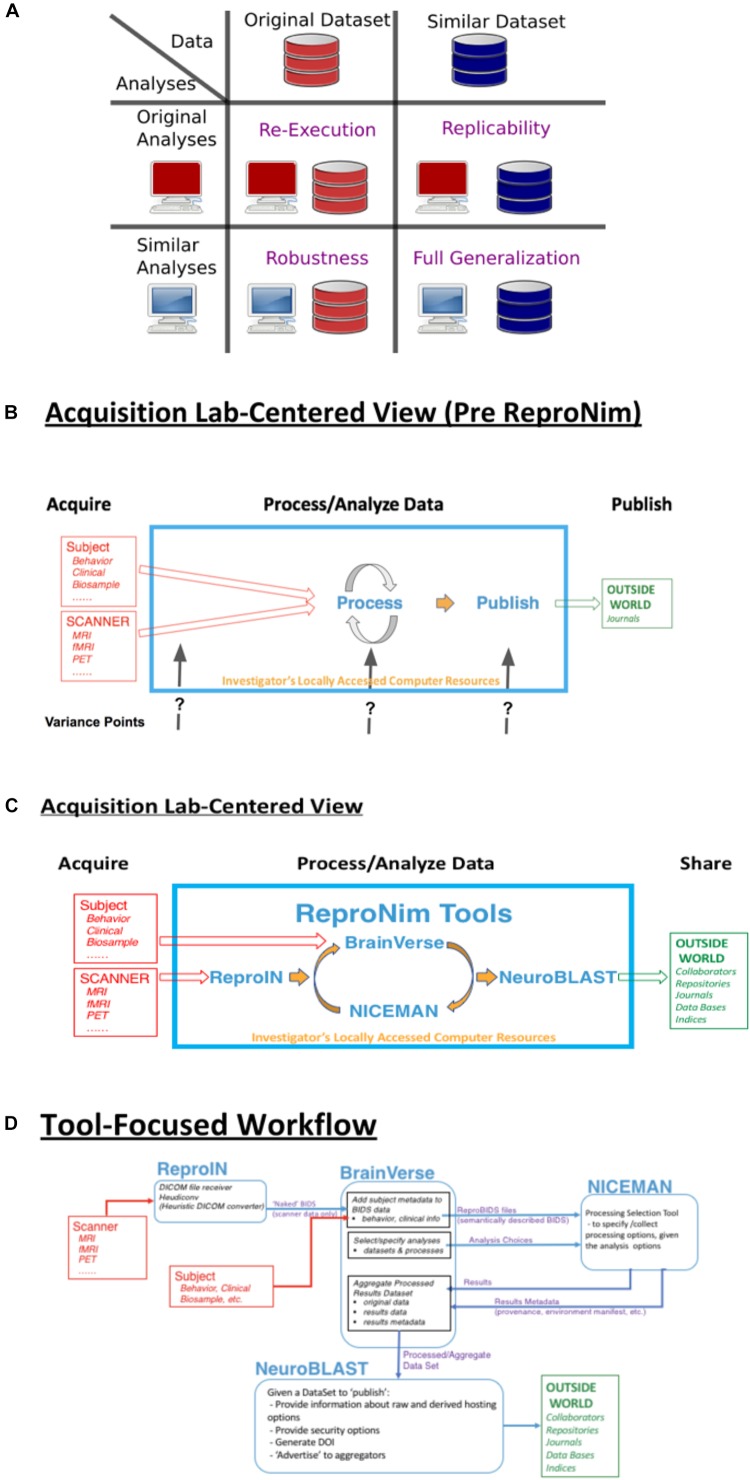
ReproNim conceptual workflows. (A) Pictorial depiction of the concepts of re-executability (same data, same analysis), replication (same analysis, similar data), robustness (same data, similar analysis), and generalization (similar data, similar analysis). Adapted from multiple sources, including Dr Drummond (2009), Peng (2011); Hong (2015), Goodman et al. (2016); Whitaker (2016), and Allard (2018). (B) General neuroimaging data workflow: Imaging data and behavioral/clinical measures enter into a local analysis, generate results that then get published. Substantial variability in the published literature exists in how the data, analysis and results are described. (C) The ReproNim vision of the general neuroimaging data workflow where control of the data model and machine-readable markup is invoked to completely represent the data workflow, processing and results using the tools of ReproIn, BrainVerse, NICEMAN, and NeuroBlast. (D) Detailed data transformations and markup as the data work their way through the planned analysis and tools.